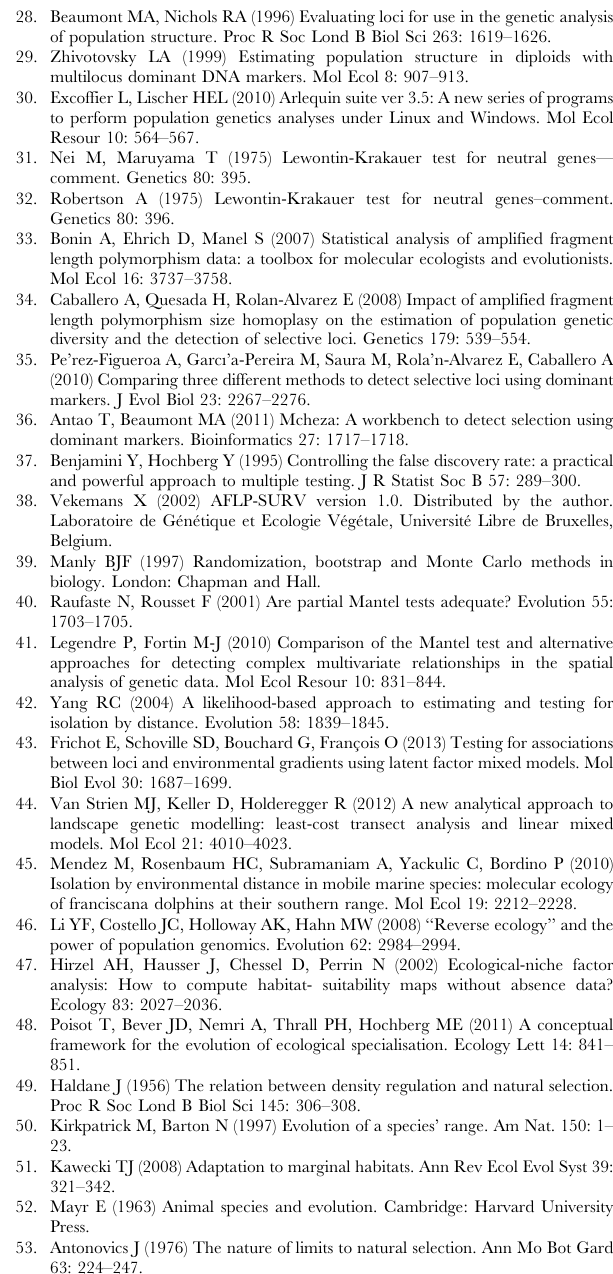
File S1 Table S1, the 31 environmental variables measured at each site and Pearson’s correlation coefficients between them. Table S2, oligonucleotide primer pairs used for selective amplification (AFLP PCR). Table S3, characteristics of the 15 non-redundant environmental variables and their relationship to allele frequency at outlier